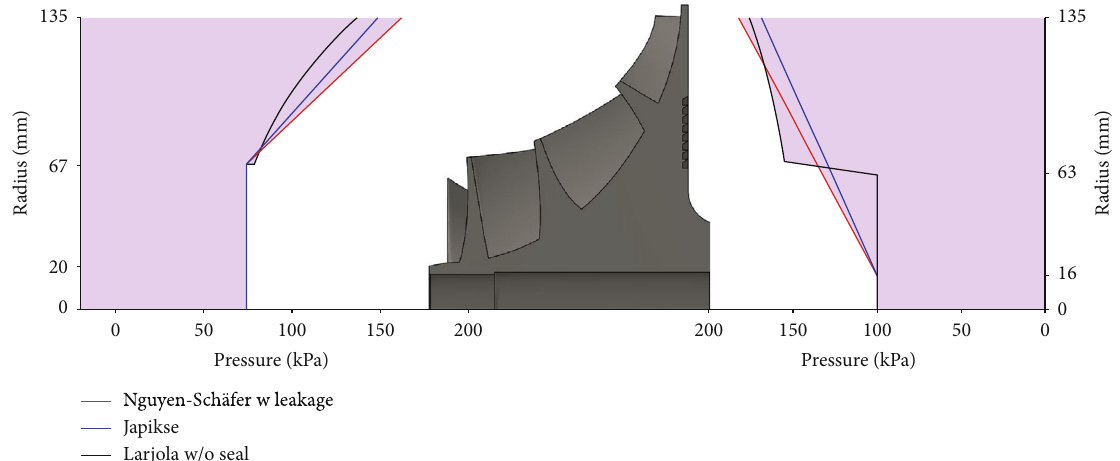
Figure 9: Pressure distributions on the shroud and back disk estimated with the three methods at the design point (point 8).